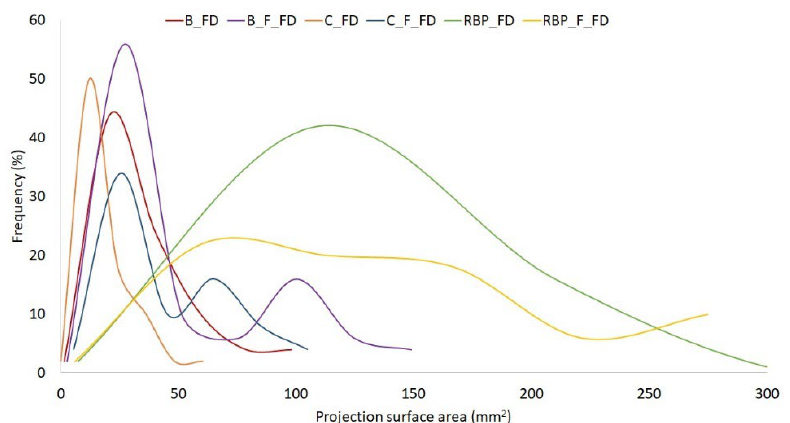
fermentation process, B—beetroot, C—carrot, RBP—red bell pepper; FD—freeze dried,